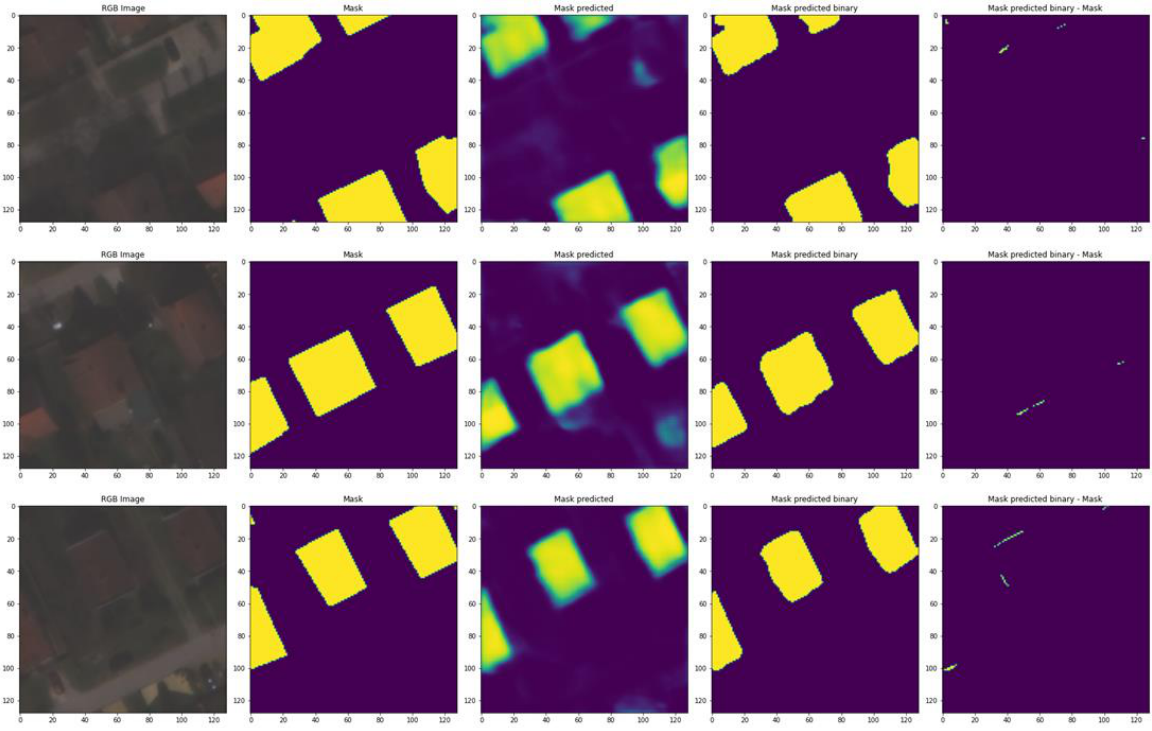
Figure 15. Test data—Subotica.